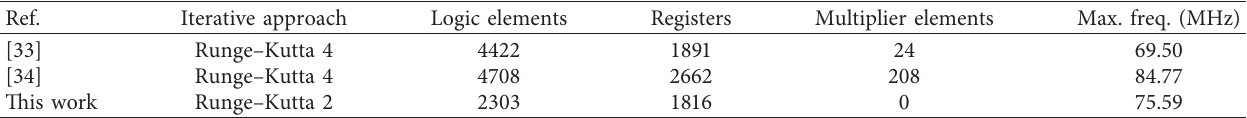
Table 3: Summary of the required resources to implement different chaotic systems by using FPGA.